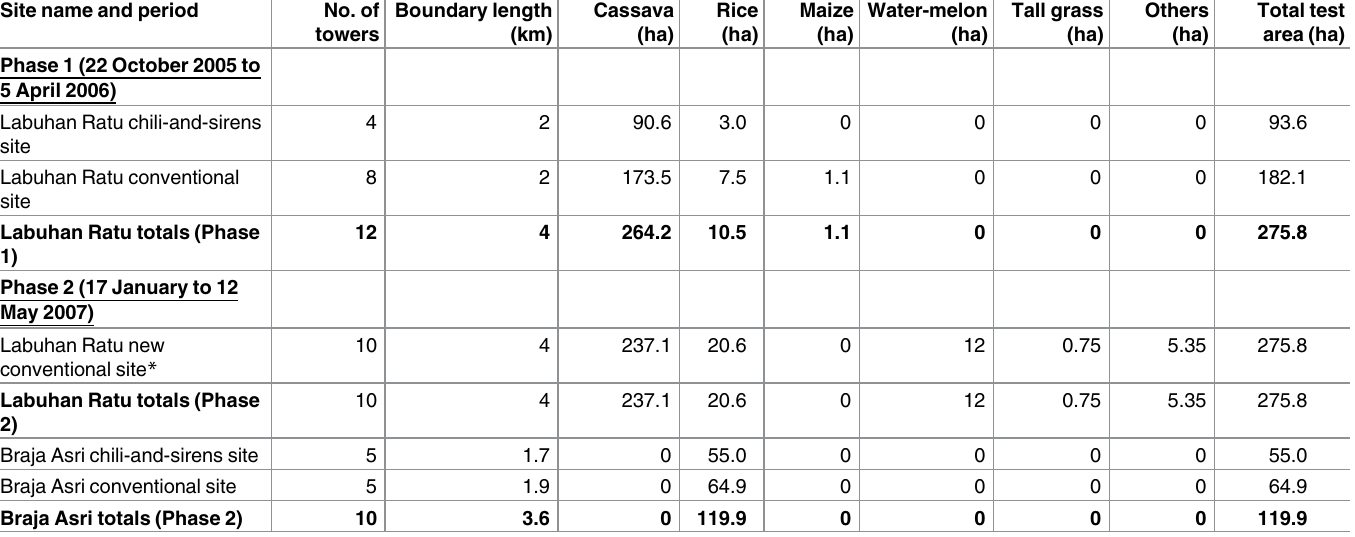
Table 2. Characteristics of the Labuhan Ratu sites in Phases1 and 2 and the Braja Asri sites in Phase